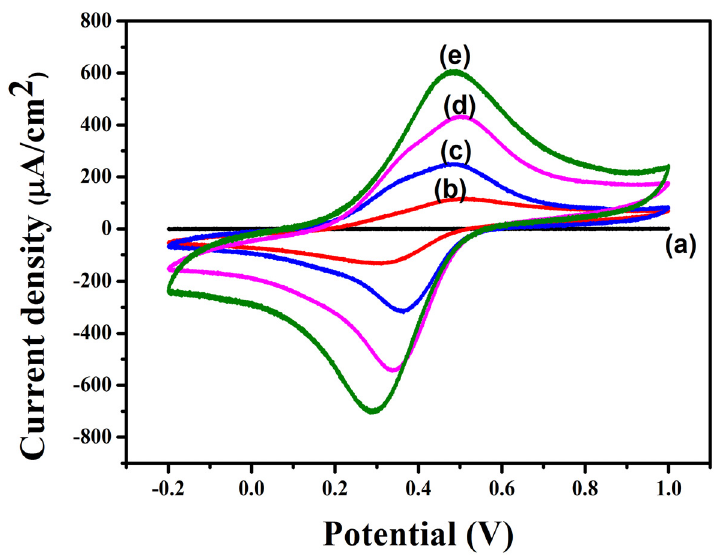
Figure 5. Electrochemical cyclic voltammetry for ( a ) ITO, ( b ) EPI, ( c ) EPIS ( d ), EPIP, and ( e ) EPIG, as measured in 1.0 M H 2 SO 4 aqueous solution with a scan rate of 50 mV s − 1 .